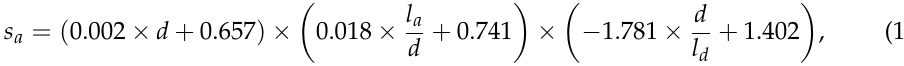
where d denotes the steel strand diameter, mm; l a denotes the embedded length, mm; l d denotes the transverse steel strand spacing, mm.